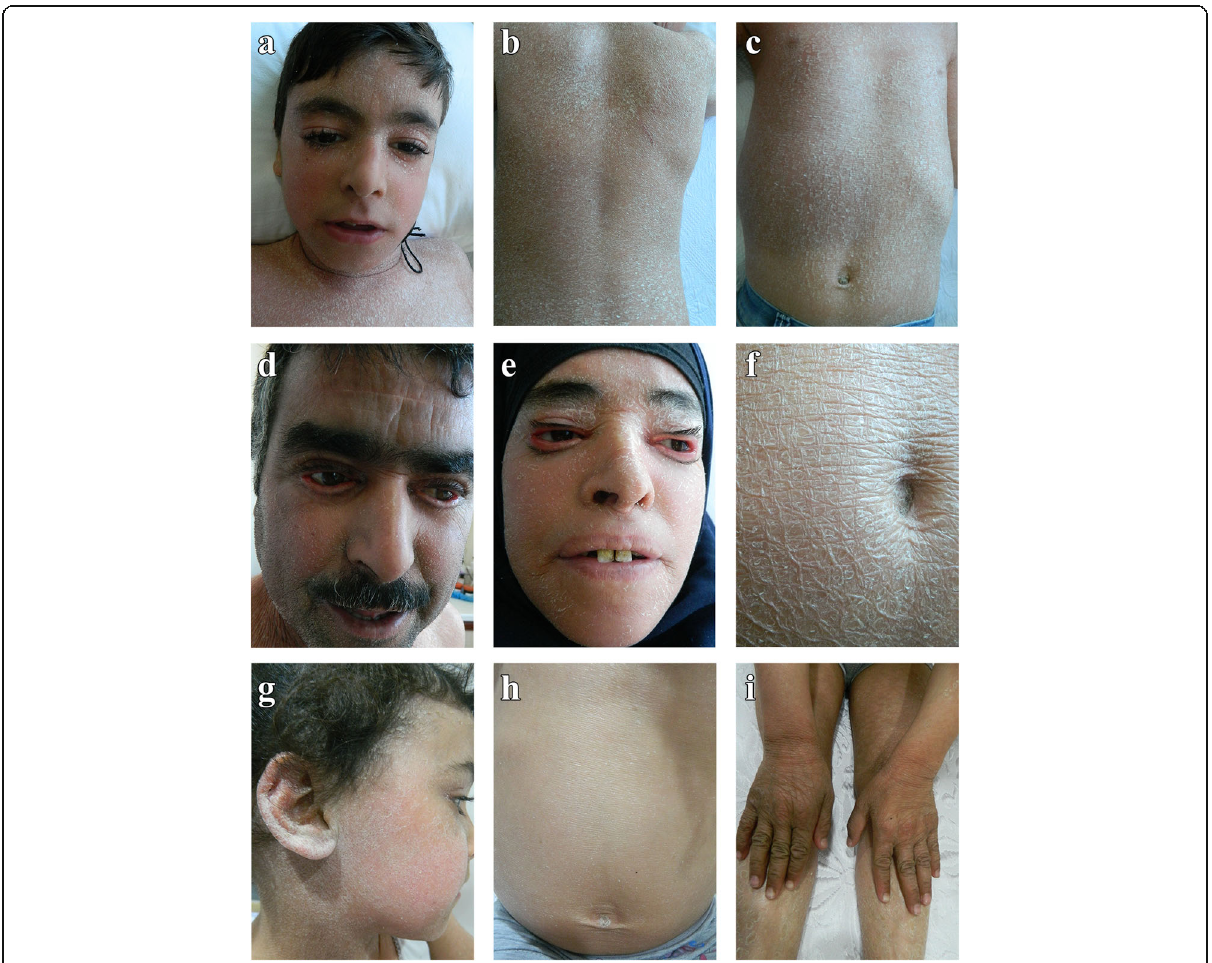
Fig. 2 Dermatological characterization of CDS patients. Lamellar ichthyosis affecting facial region ( a , d , e , g ), trunk ( b , c , f , h ), and extremities ( i ) of child (patient IV-1; a , b , c ), father (patient III-2; d ), mother (patient III-1; e , f ) and cousin (patient IV-2; g , h , i ). Prominent eyelid ectropion in father ( d ) and mother ( e